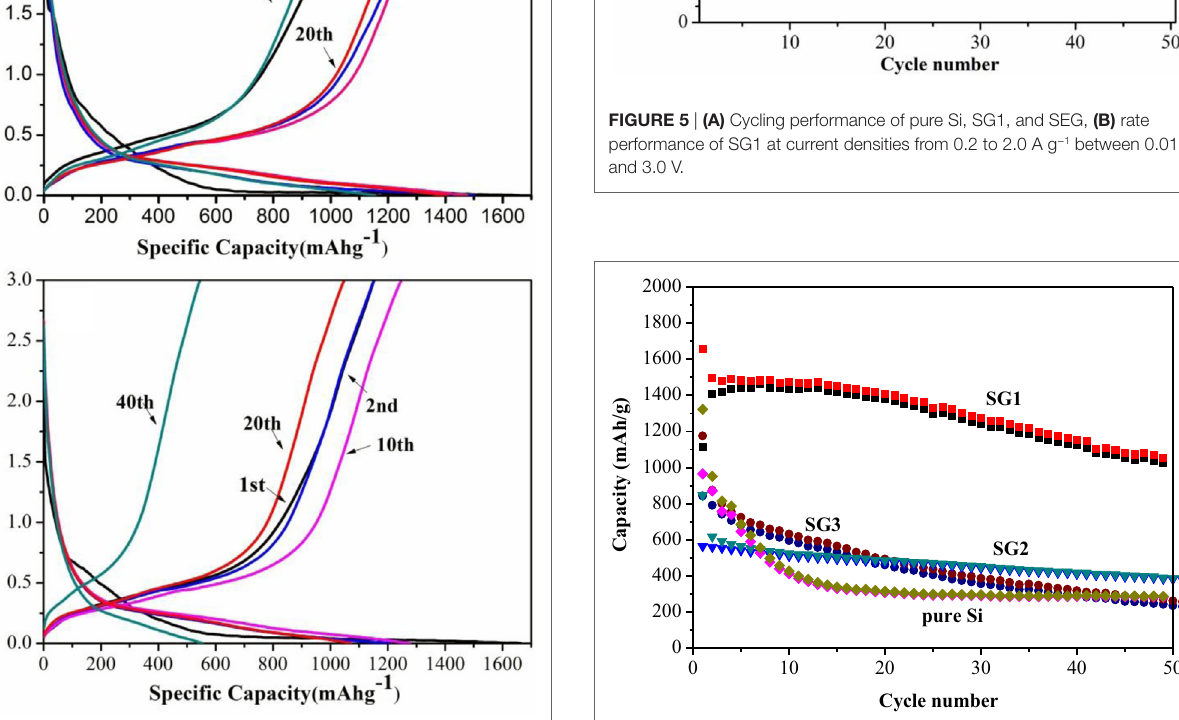
FigUre 4 | Typical charge–discharge curves of SG1 (a) and SEG (B) cycled at the 1st, 2nd, 10th, 20th, and 40th between 0.01 and 3.0 V.